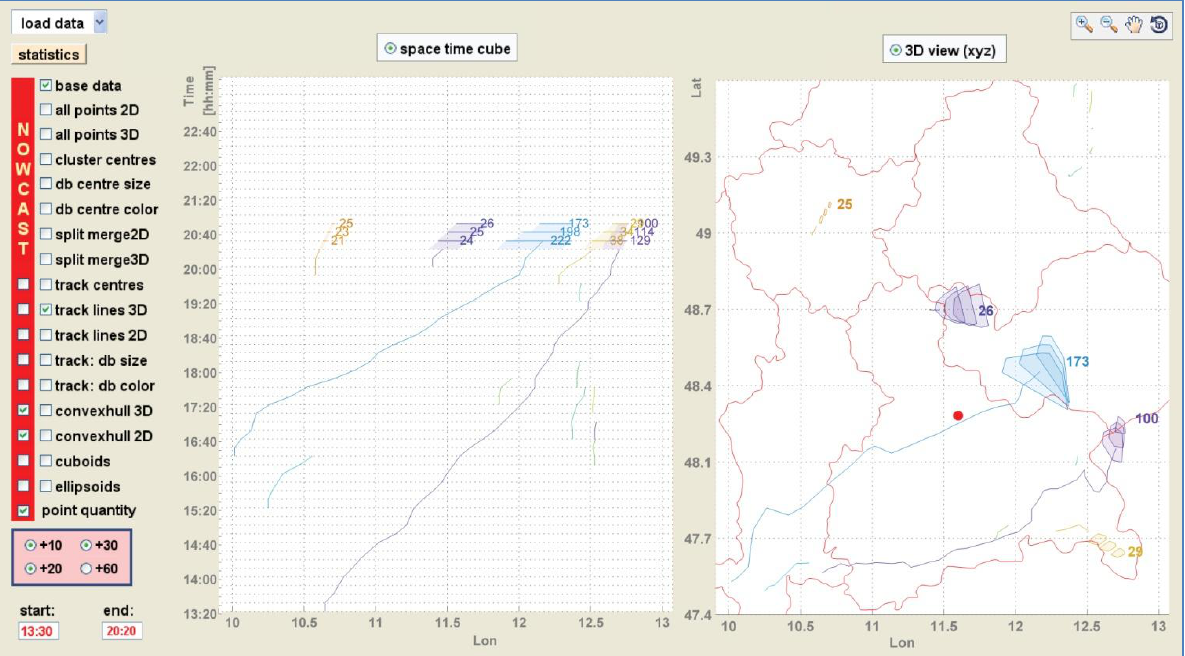
Figure 7. Tendency of value change in nowcasted cluster features (extension and density).